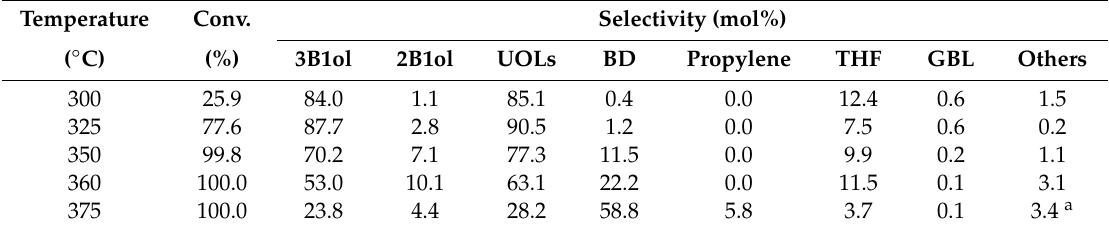
Table 6. Dehydration of 1,4-BDO over YZrO at di ff erent reaction temperatures.